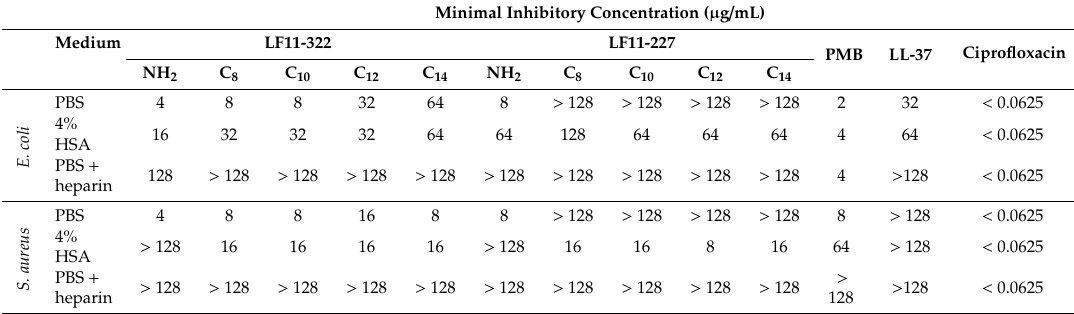
Table 1. Minimum inhibitory concentrations of AMPs, Polymyxin B (PMB), and Ciprofloxacin for E. coli and S. aureus in aqueous solution, in human serum albumin, and in heparin (5 IU / mL) containing